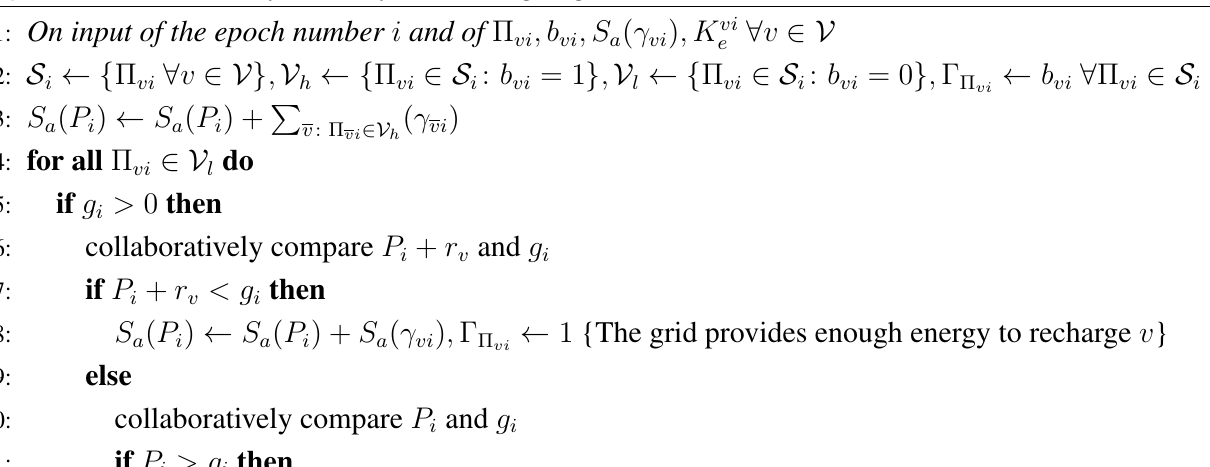
Algorithm 1 The Privacy-Friendly Scheduling